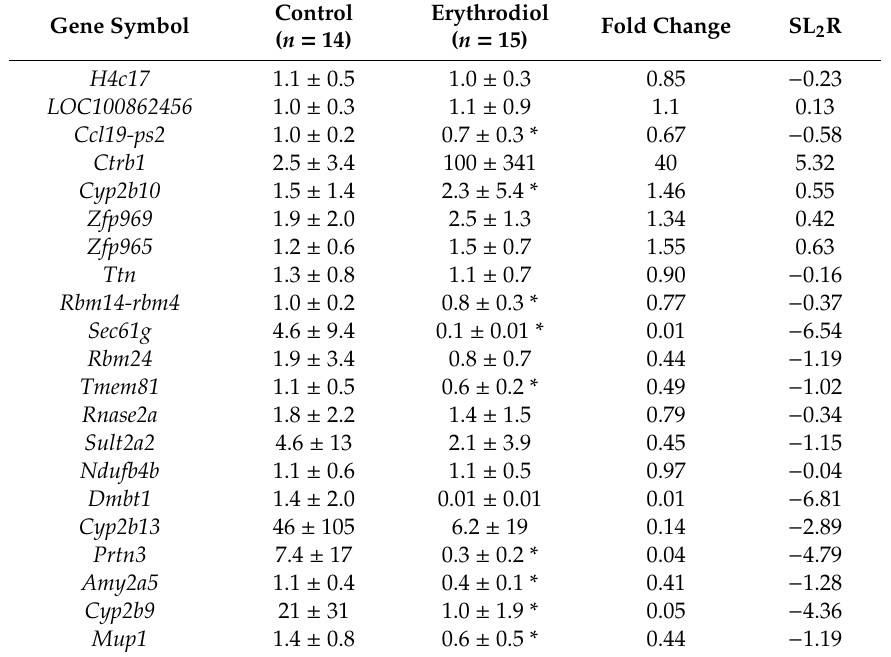
Table 3. Changes in selected hepatic gene expressions of male Apoe -deficient mice receiving 10 mg / kg erythrodiol according to RT-qPCR